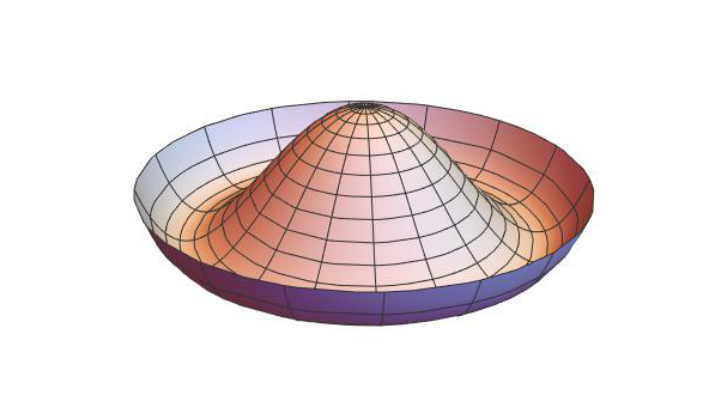
Figure 11: The Mexican Hat